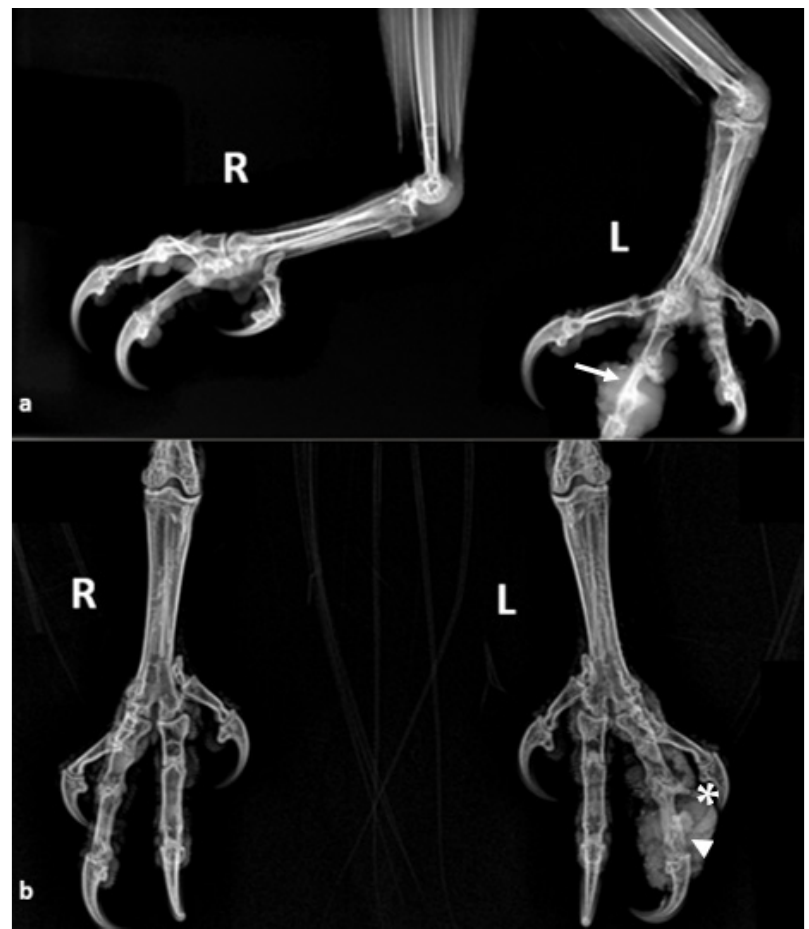
Figure 1. Verreaux’s eagle owl feet pretreatment. Lateral ( a ) and dorsoplantar ( b ) radiographs taken prior to removal of the cable tie showing changes to phalanx 2 of digit three in the left foot. There is narrowing of the bone (white arrow) compared with the bone of the contralateral foot and osteolysis is present (white arrowhead). Osteophyte formation can be appreciated at both ends of the bone, particularly the proximal end (white asterisk).